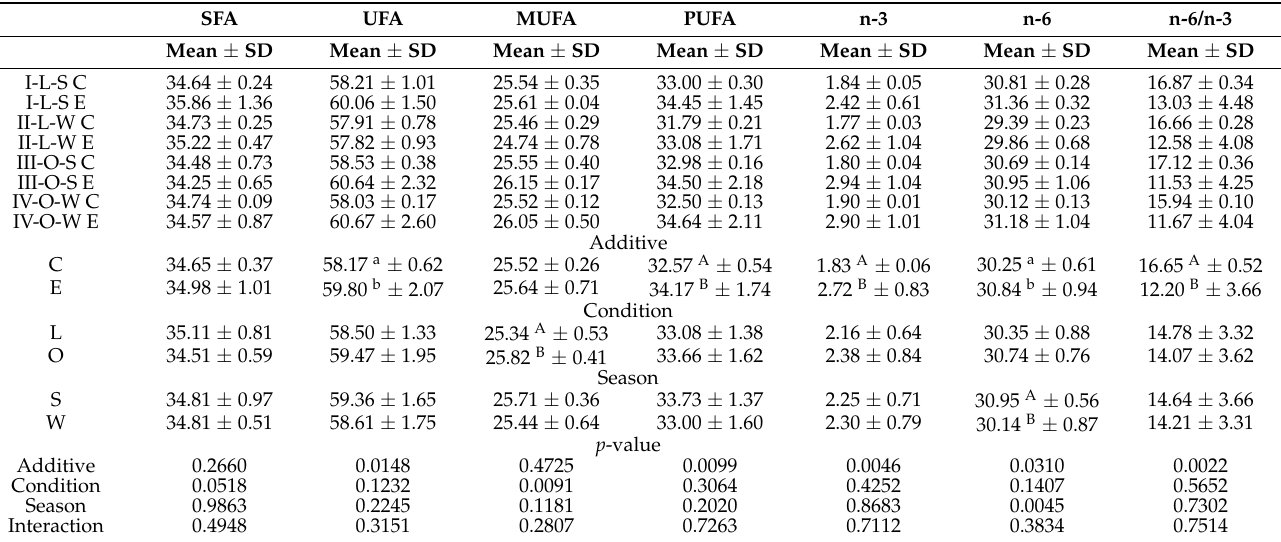
Table 8. Fatty acid profile in rabbit blood